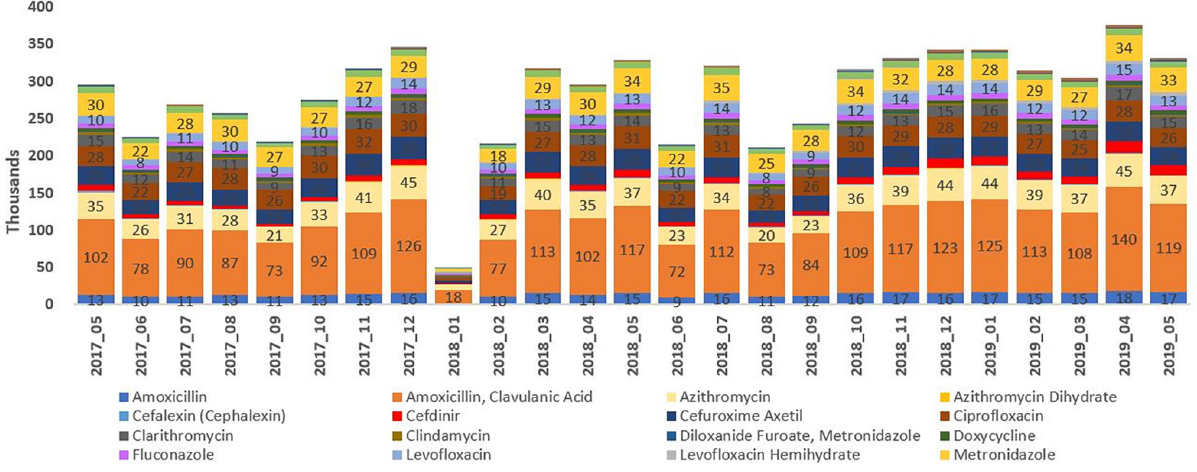
Fig 5. Antimicrobial claims (by molecule) in the year pre- and post-policy enforcement.